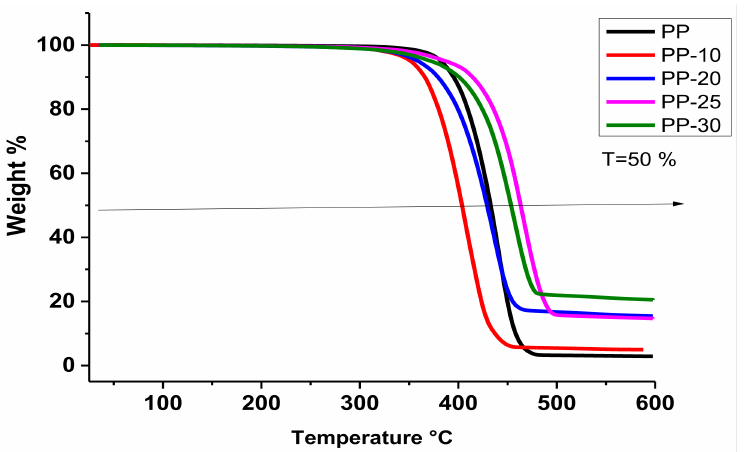
Figure 4. Thermograms of PP/TiO 2 /lignin composites obtained by extrusion. For polymer PP, its weight loss started at 258 ◦ C and ended at 482 ◦ C, while the PP-10